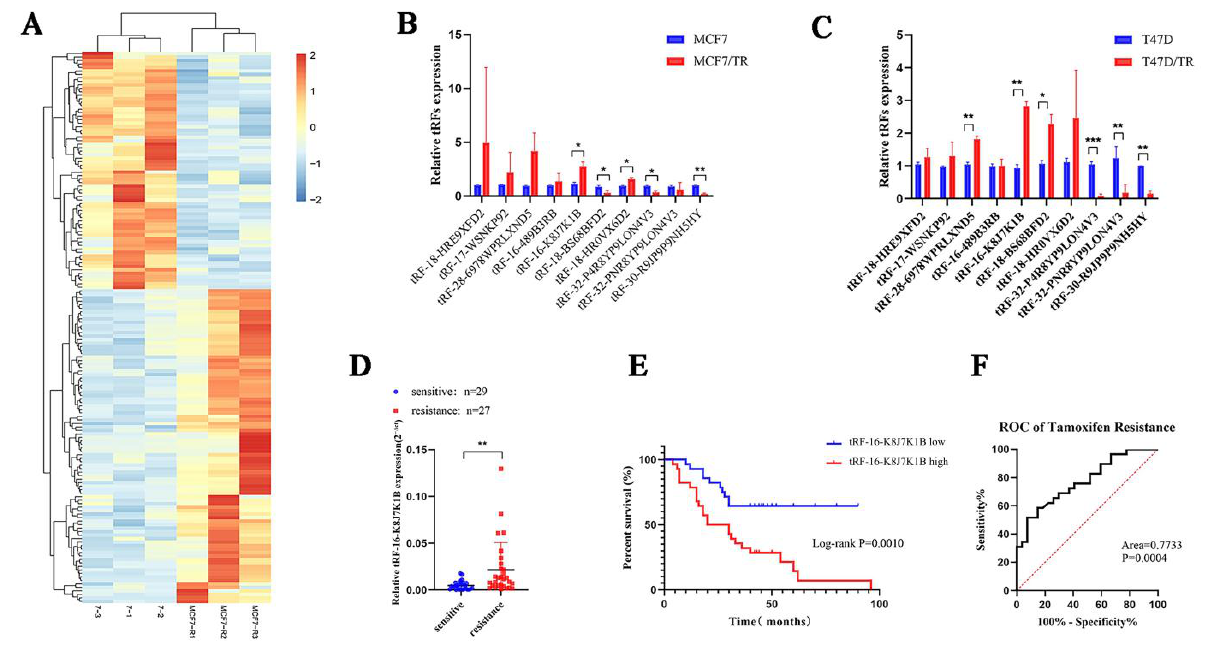
Figure 1. tRF-16-K8J7K1B is upregulated in tamoxifen-resistant breast cancer patients and correlates with shorter DFS in patients. ( A ) Heatmaps of differently expressed tRFs and tiRNAs in tamoxifen- sensitive and resistant cell lines. ( B ) The 10 candidate differentially expressed tRFs and tiRNAs in MCF7/S and MCF7/TR cells. ( C ) The 10 candidate differentially expressed tRFs and tiRNAs in T47D/S and T47D/TR cells. ( D ) RT-qPCR analysis revealed the relative expression of tRF-16-K8J7K1B in serum of tamoxifen-sensitive and tamoxifen-resistant patients. ( E ) Patients with high levels of tRF-16-K8J7K1B expression had significantly worse DFS. ( F ) ROC curve analysis showed the power of tRF-16-K8J7K1B in predicting tamoxifen resistance. Data are presented as mean ± SEM. * p < 0.05; ** p < 0.01; *** p < 0.001.